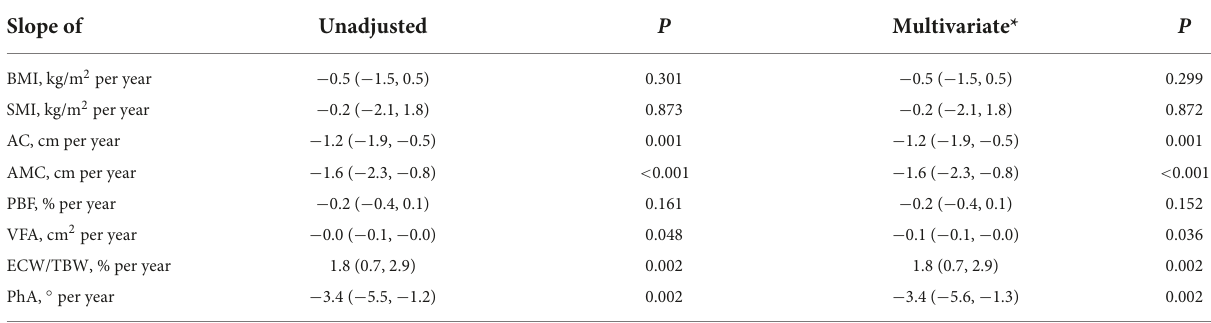
TABLE 3 Impact of body composition slope on the pattern of ERI over time. Change in ERI trajectory over time, IU/kg/week/g/dL per year Slope of Unadjusted